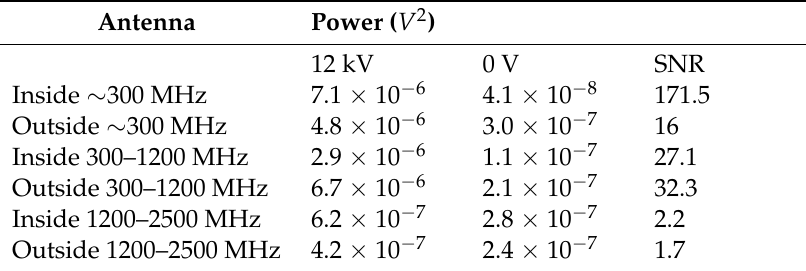
Table 10. Accumulated power and SNR for surface PD in insulator over the tank when measured with the inner and the outer 10 cm